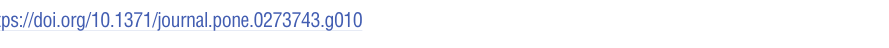
Fig 10. Heatmap for Pearson’s correlation coefficients between observed traits for Spiraea taxa (r 0.05 = 0.38; r 0.01 = 0.49; r 0.001 =